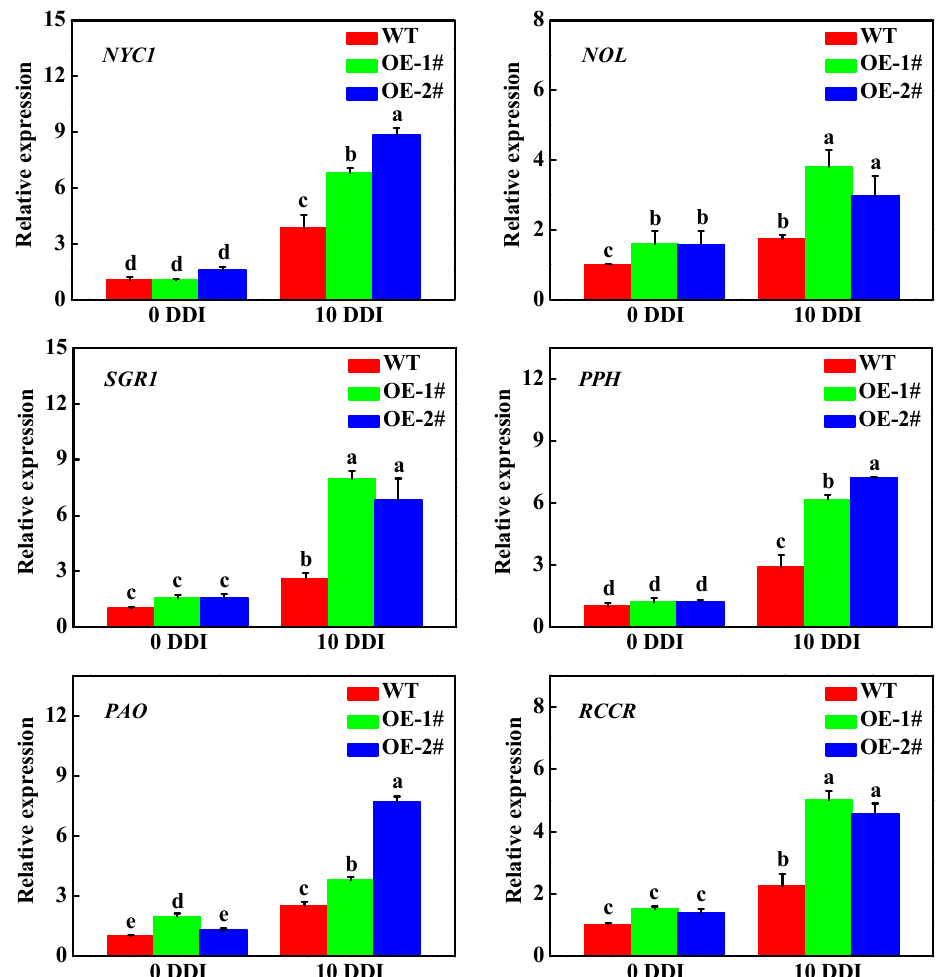
Figure 5. Expression of chlorophyll degradation related genes in leaves of wild-type and CsHCAR overexpression tobacco seedlings. The results represent the mean ± SE ( n = 3). Means with the same letter did not significantly differ at p < 0.05 according to Tukey’s test. WT, wild-type; OE-1# and OE-2#, 2 independent transgenic tobacco overexpression of CsHCAR . DDI, day(s) of dark incubation; NYC1 , non-yellow coloring1; NOL , NYC1-like; SGR1 , stay-green1; PPH , pheophytinase; PAO , pheophorbide a oxygenase; RCCR , red chlorophyll catabolite reductase.